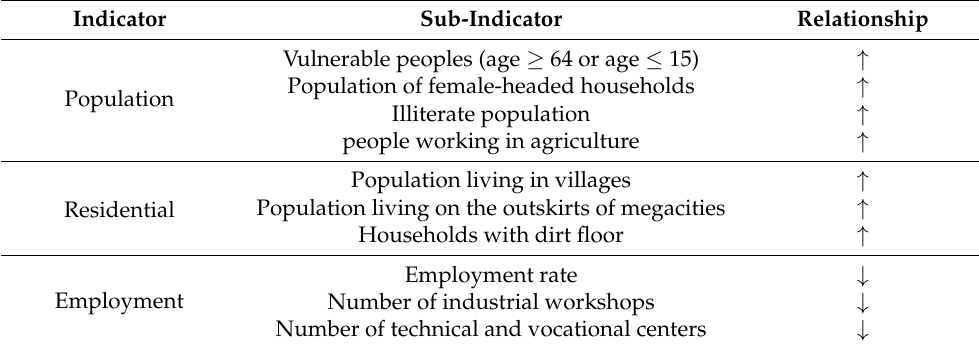
Table 3. Sensitivity indicators and sub-indicators and their functional relationship with drought vulnerability. Indicator Sub-Indicator Relationship Vulnerable peoples (age ≥ 64 or age ≤ 15) ↑ Population of female-headed households Population Illiterate